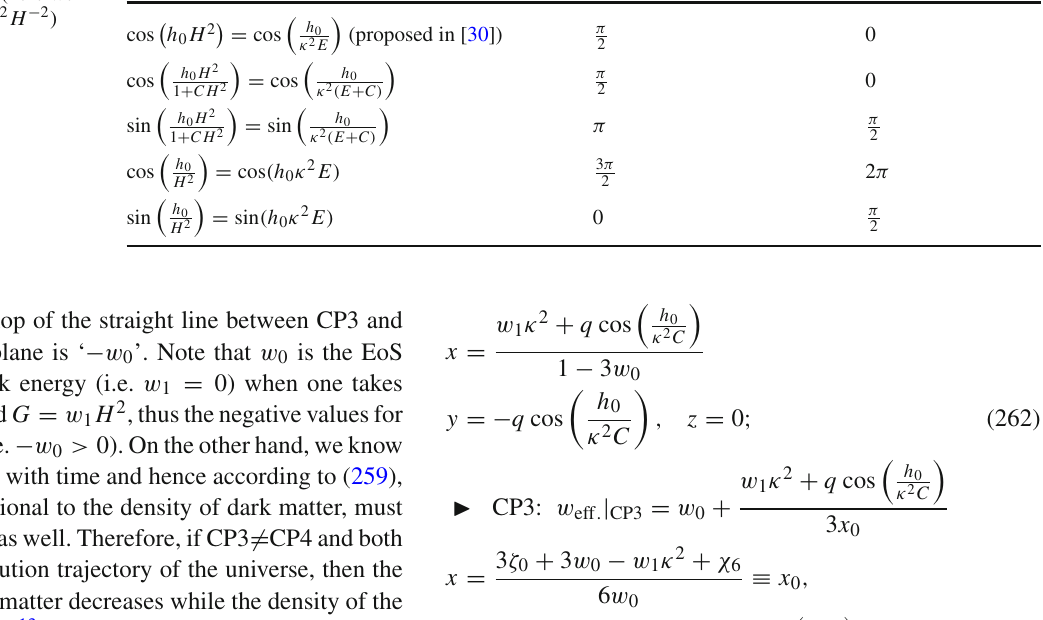
Table 2 The evolution ranges of The interaction models; cos (θ) and sin (θ) Inflationary epoch; θ the interaction models (here we have assumed E = κ − 2 H − 2 )